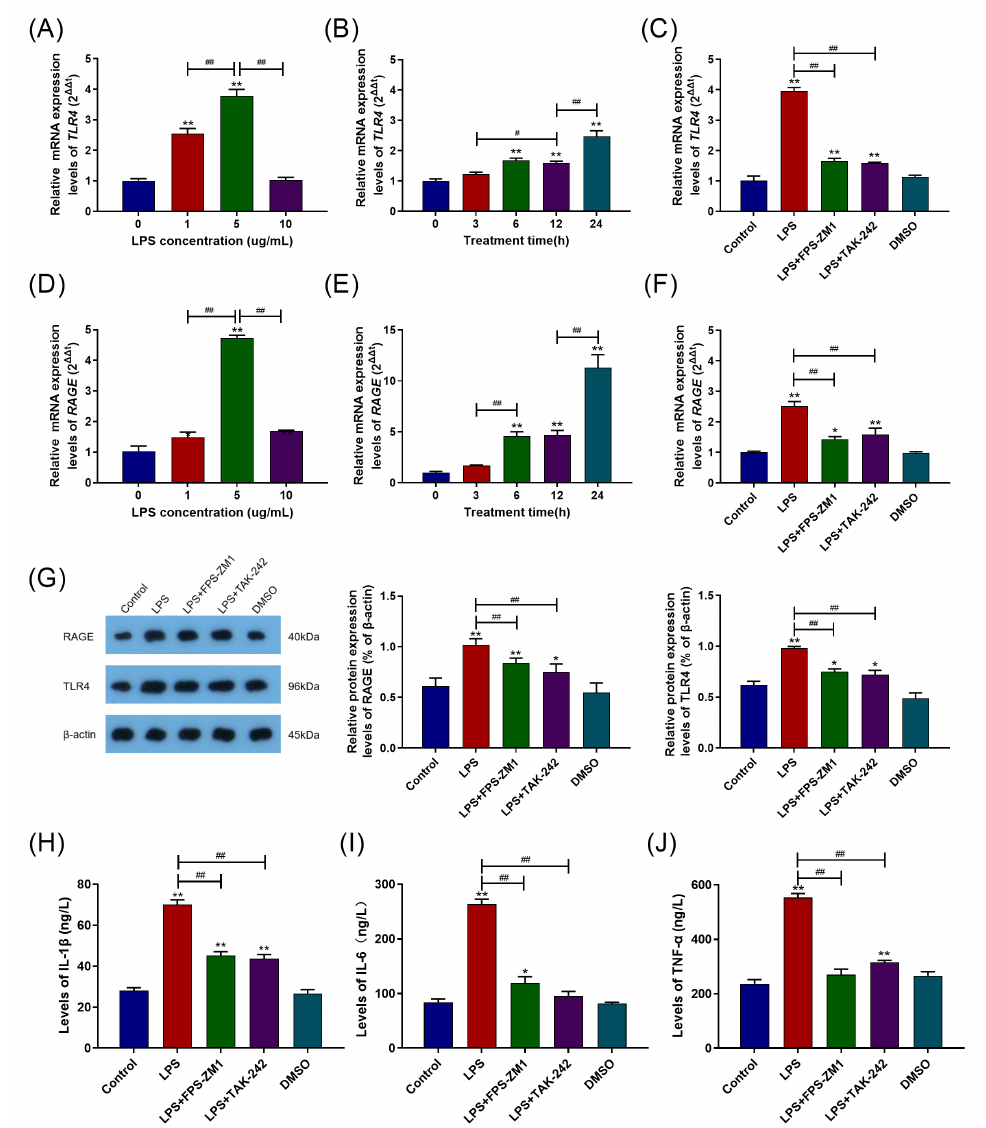
Figure 2. TLR4, RAGE and their interaction were involved in LPS-induced inflammatory response in BAMs. ( A , D ) Effects of different LPS concentrations (0, 1, 5, and 10 µ g/mL) on the levels of TLR4 and RAGE mRNA expression. ( B , E ) Effects of different LPS treatment time (0, 3, 6, 12, and 24 h) on the levels of TLR4 and RAGE mRNA expression. ( C , F ) Effects of pretreatment with FPS-ZM1 and TAK-242 on the levels of TLR4 and RAGE mRNA expression. ( G ) Comparison of gel images and grayscale for RAGE and TLR4 immunoblot detection. ( H – J ) The levels of IL-1 β , IL-6, and TNF- α in the supernatants of each group. Each experiment was carried out at least three times, and the data were displayed using mean ± SD. *, p < 0.05; **, p < 0.01 vs. control group; # , p < 0.05; ## , p < 0.01 vs. other treatment groups ; One - way ANOVA.